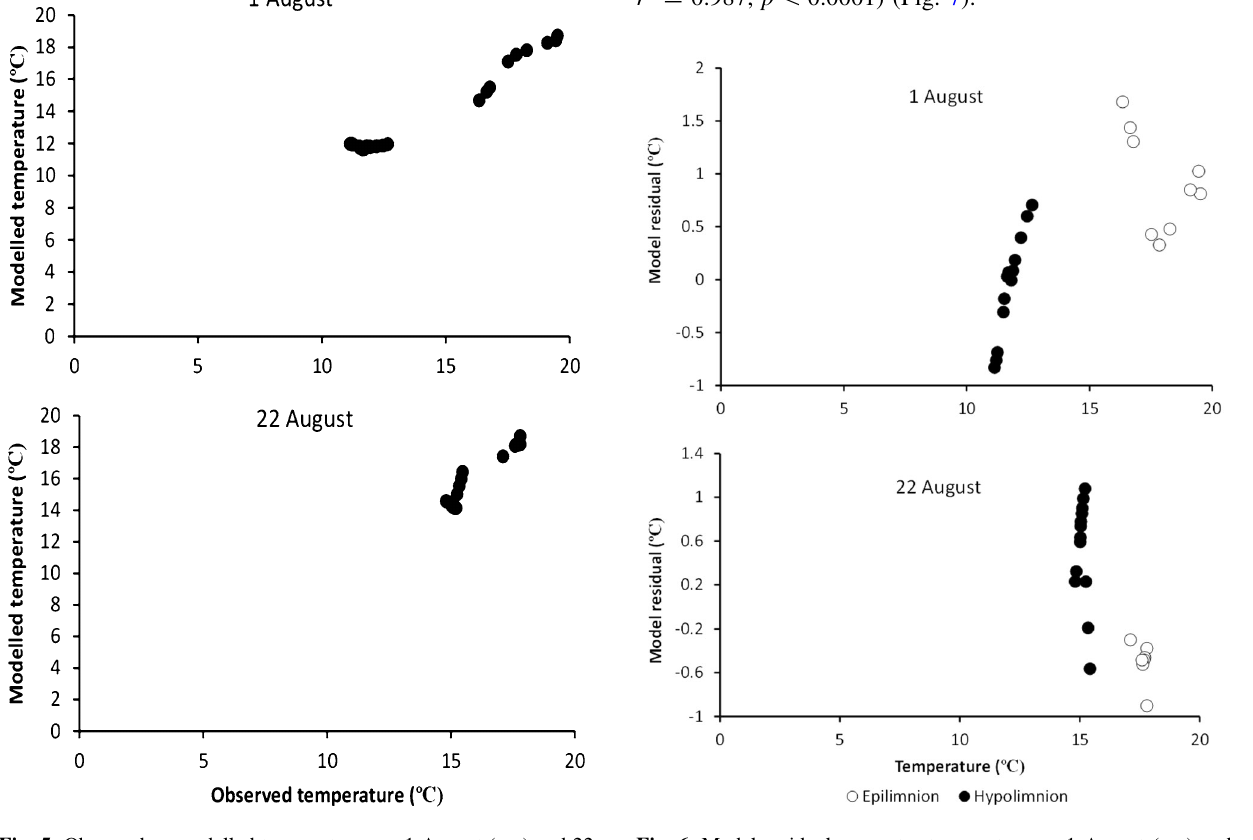
Fig. 6 Model residuals vs water temperature on 1 August ( top ) and 22 August ( bottom